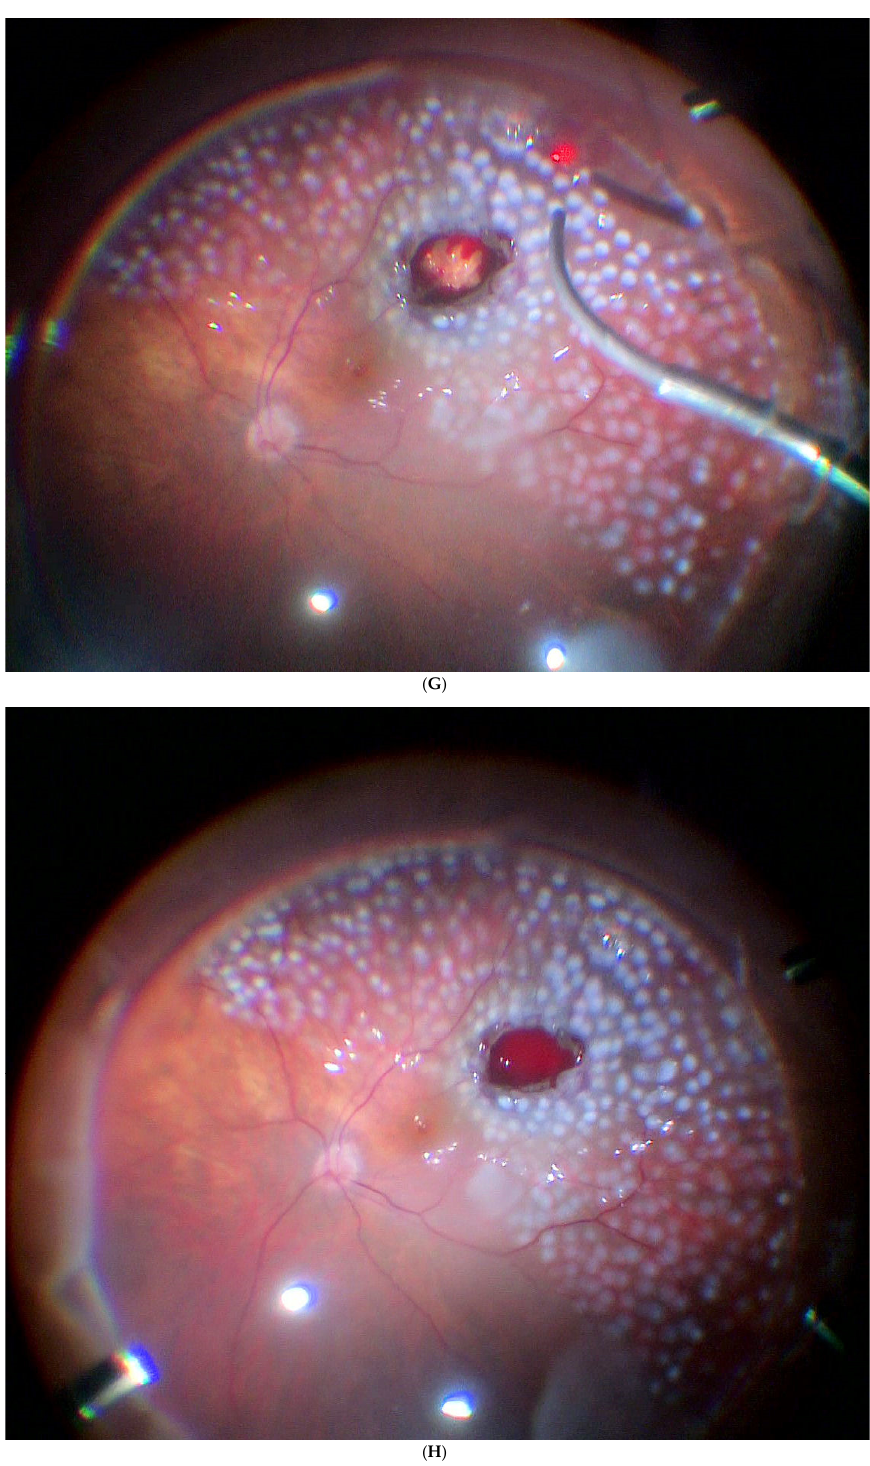
Figure 3. Ab interno resection technique. ( A ). First, phacoemulsification cataract surgery is per- formed. ( B ). Mushroom-shaped choroidal melanoma located on the superior temporal arcade with extensive retinal detachment. ( C ). Liquid perfuorocarbon is injected to flatten the retina. ( D ). Endo- photocoagulation is performed around the tumour. ( E ). Resection is initiated by introducing the vitrectomy probe into the tumour. A low cutting rate and high aspiration is programmed, and the tumour is fragmented into pieces and aspirated. ( F , G ). The resection is completed until the bare sclera is reached. It is possible to leave a remnant since it will be treated by brachytherapy. ( H ). Perfluorocarbon liquid is then exchanged for silicone. At this stage, a hemorrhage may occur, which overlies the coloboma. Finally, a radioactive plaque is placed at the base of the tumour.